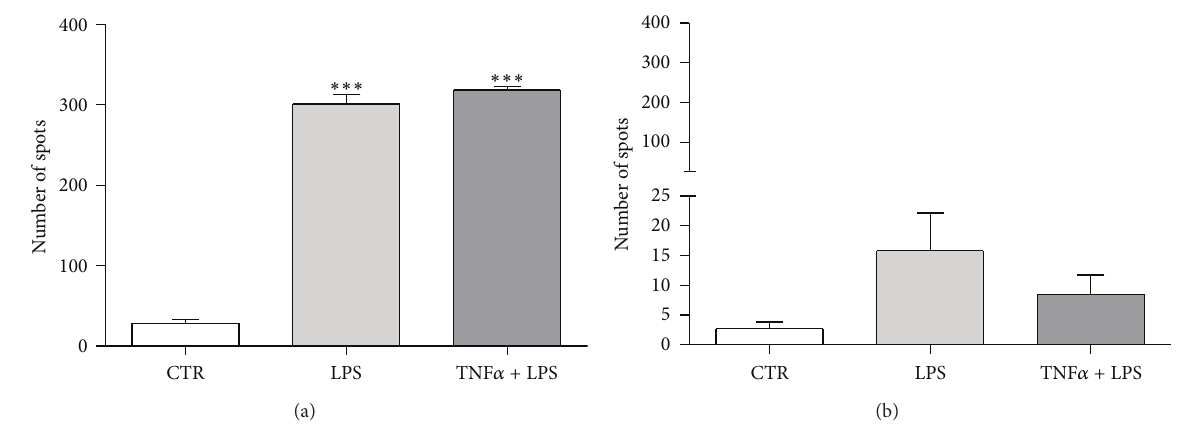
Figure 2: Number of spots after incubation of epithelial cells (a) or stromal cells (b) with LPS at 50ng mL −1 or LPS plus TNF 𝛼 (at 50 ngmL −1